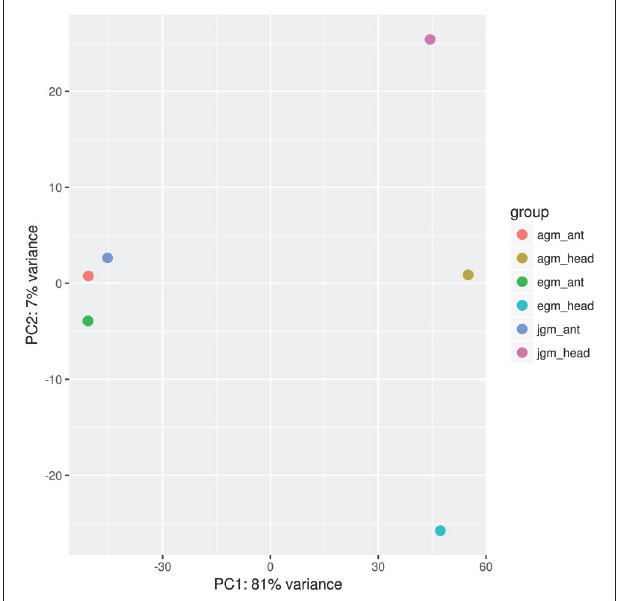
FIGURE 2 | Principal component analysis (PCA), comparing the normalized gene expression patterns for the female antennae (ant) and the larval head capsule (head) transcriptomes of three subspecies of the Gypsy moth ( L. dispar ). The flight capable AGM (Asian gypsy moth) and JGM (Japanese gypsy moth), and the flightless EGM (European gypsy